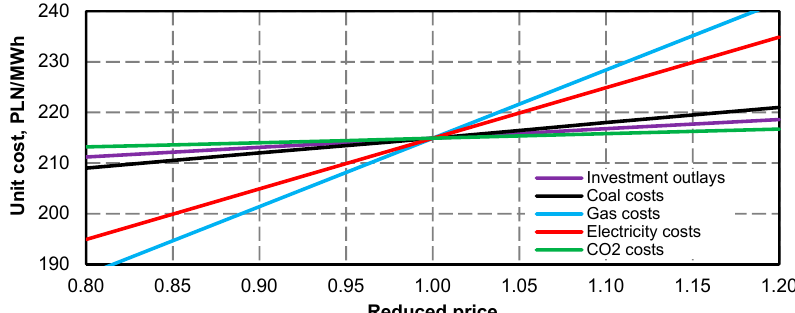
Figure 51. The impact of investment outlays, gas cost, unit cost of power generation before the upgrade, the cost of CO 2 emission permits on the unit cost of electric power generation in the upgraded power unit for operating the gas turbine at a rated power and a single-pressure recovery boiler.